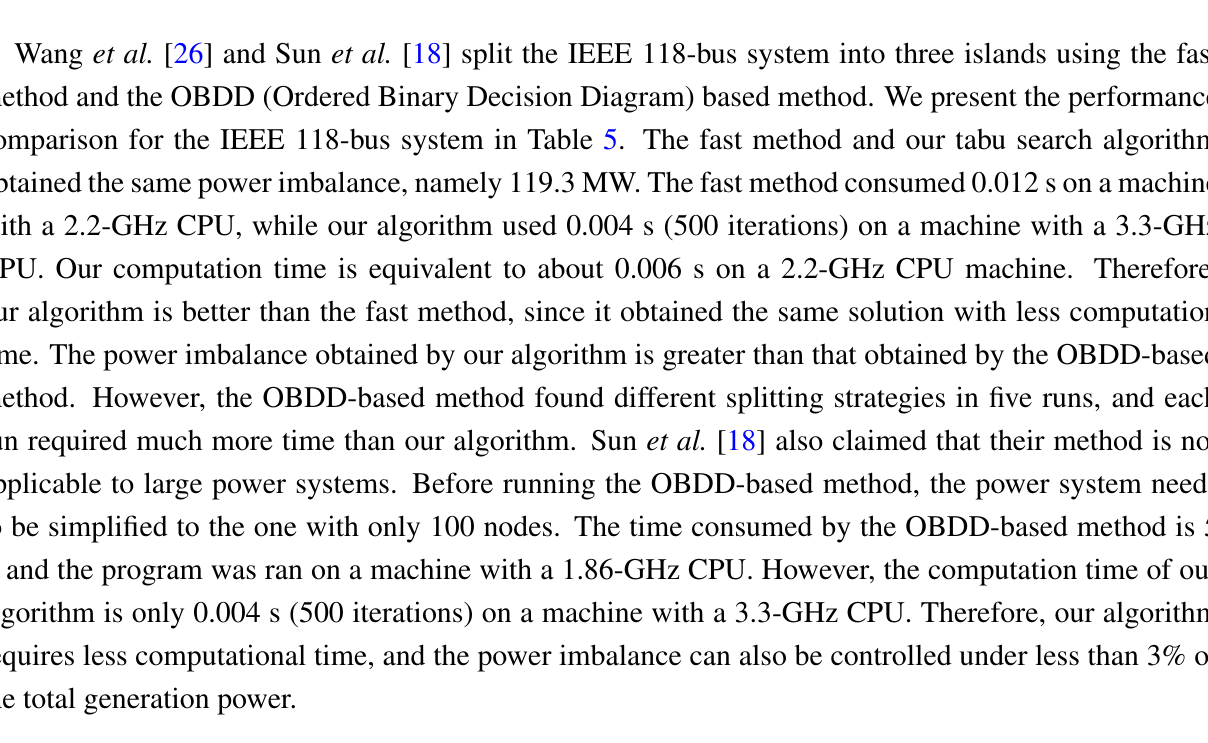
Table 5. Performance comparison for the IEEE 118-bus system. OBDD (Ordered Binary Decision Diagram), ordered binary decision